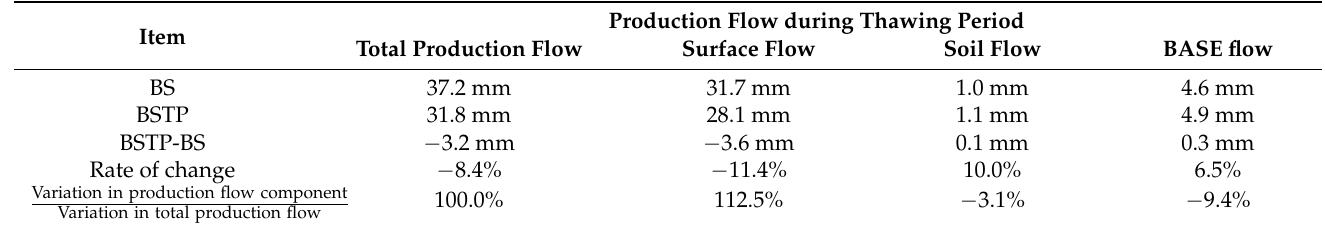
Table 10. Influences of temperature and precipitation on runoff component variation during the thawing